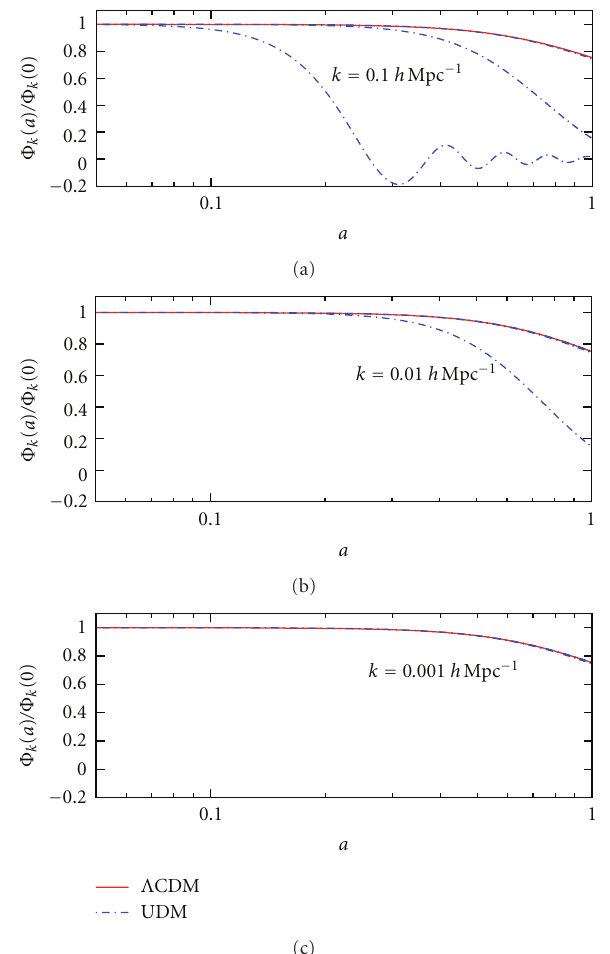
Figure 6: Normalized potentials Φ k ( a ) / Φ k (0) are shown for Λ CDM (solid) and UDM (dot-dashed) (see [41]). The lower panel shows potentials at k = 0 . 001 h Mpc − 1 , the medium panel at k = 0 . 01 h Mpc − 1 , and the upper panel at k = 0 . 1 h Mpc − 1 . UDM curves are for c ∞ 2 = 10 − 6 ,10 − 4 ,10 − 2 from top to bottom, respectively. At small c ∞ , Λ CDM and UDM curves are